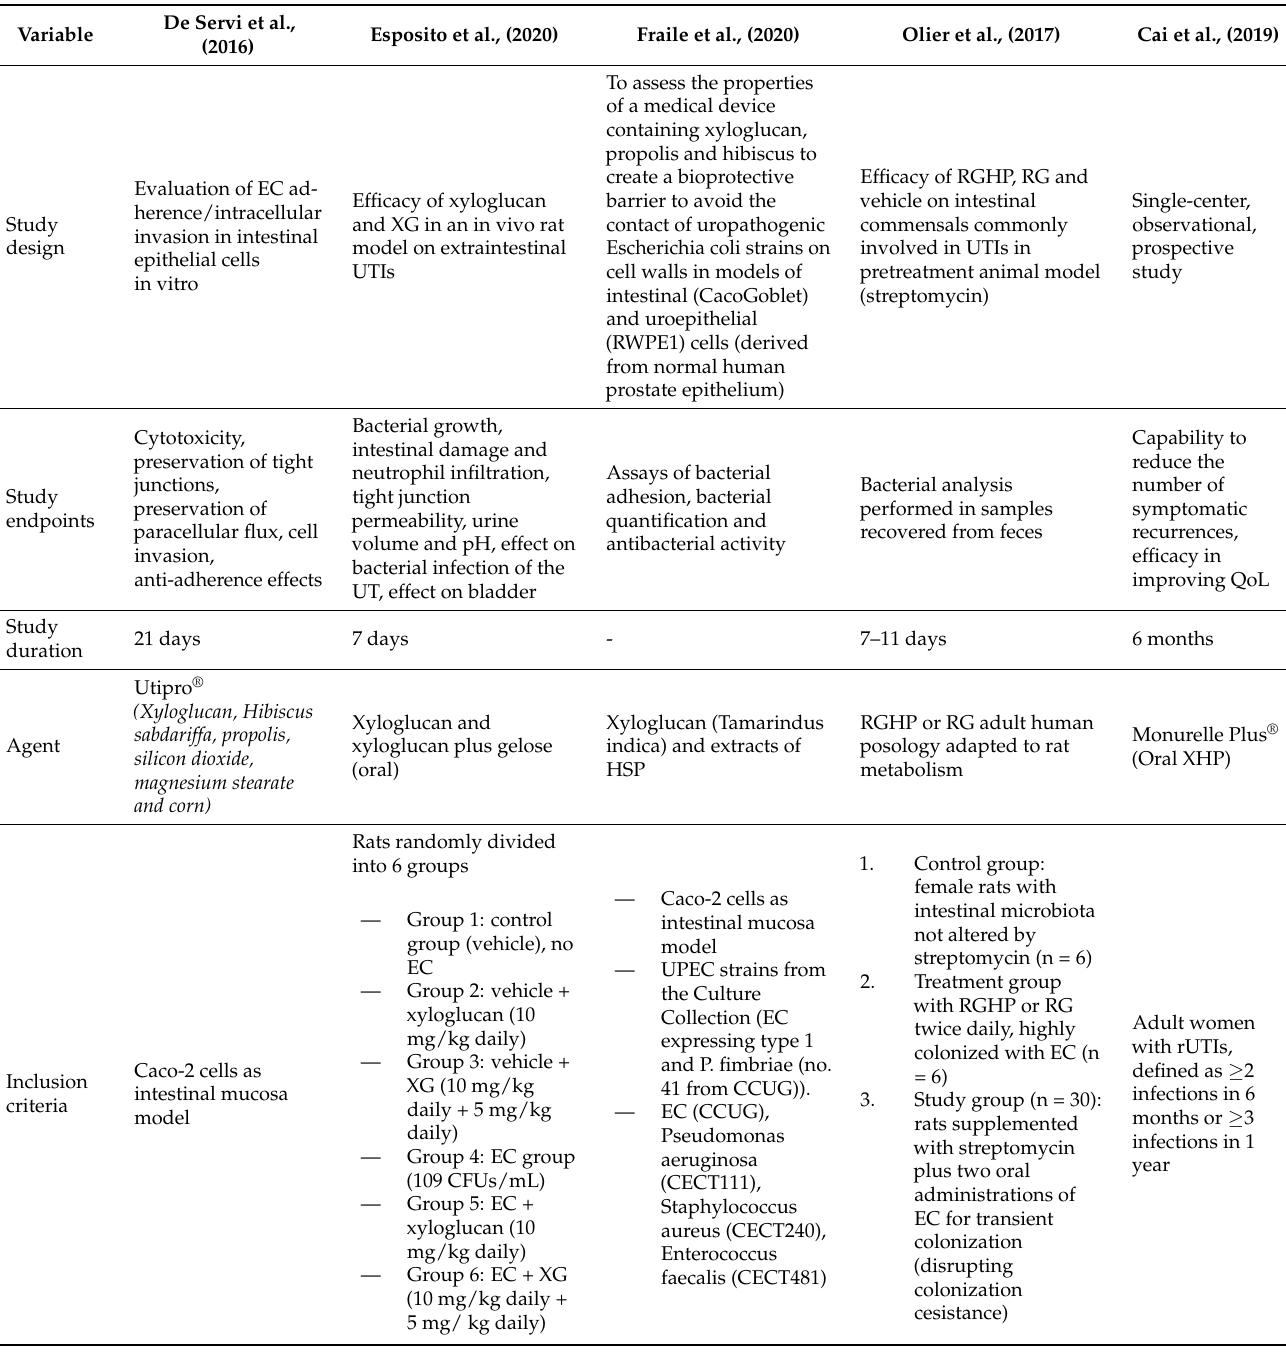
Table 1. The table shows all characteristics of all pre-clinical and non-randomized clinical studies. List of abbreviations used in table: MD = medical device; RGHP = reticulated-gelatin hibiscus and propolis; RG = reticulated gelatin (RGHP); SRR = symptomatic recurrence reduction; UTI = urinary tract infection; rUTI = recurrent urinary tract infection; XGHP =